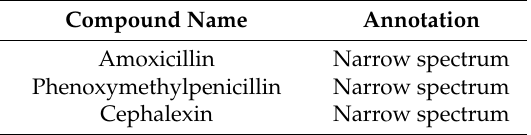
Table 4. True pathogenic antimicrobials predicted by the best classifier on the discovery